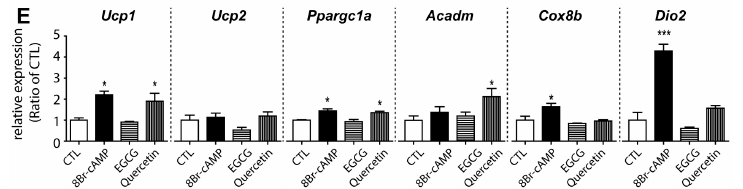
Figure 3. Establishment of BA cell lines and effects of EGCG on brown adipocyte marker expression in adipocyte cultures. Immunoblot analysis of UCP1, perilipin1 (PLIN1), and COXIV expression ( A ) and quantitative PCR analysis of UCP1 expression ( B ) in adipocytes differentiated from 3T3L1, C 3 H 10 T1/2, and immortalized preadipocytes isolated from iBAT. Two-way ANOVA revealed significant main effects of treatment ( p = 0.0165) and cell types ( p < 0.0001) in UCP1 expression and significant interaction of treatment and cell types ( p = 0.0060). Significant differences between control and treated group were determined by post-hoc pairwise comparison with Bonferroni correction (mean ± SEM; n = 4 per condition, *** p < 0.001). ( C ) Quantitative PCR analysis of brown adipocyte gene expression in adipocytes differentiated from 3T3L1 treated with 8Br-cAMP (1 mM), EGCG (10 μ M) and quercetin (10 μ M) for 24 h. Immunoblot analysis of UCP1 expression ( D ) and quantitative PCR analysis ( E ) of brown adipocyte gene expression in adipocytes differentiated from BA cell lines treated with 8Br-cAMP (1 mM), EGCG (10 μ M) and quercetin (10 μ M) for 24 h. p values were calculated using the two-tailed unpaired t -test ( n = 3, means ± SE; * p < 0.05, ** p < 0.01, *** p < 0.001).